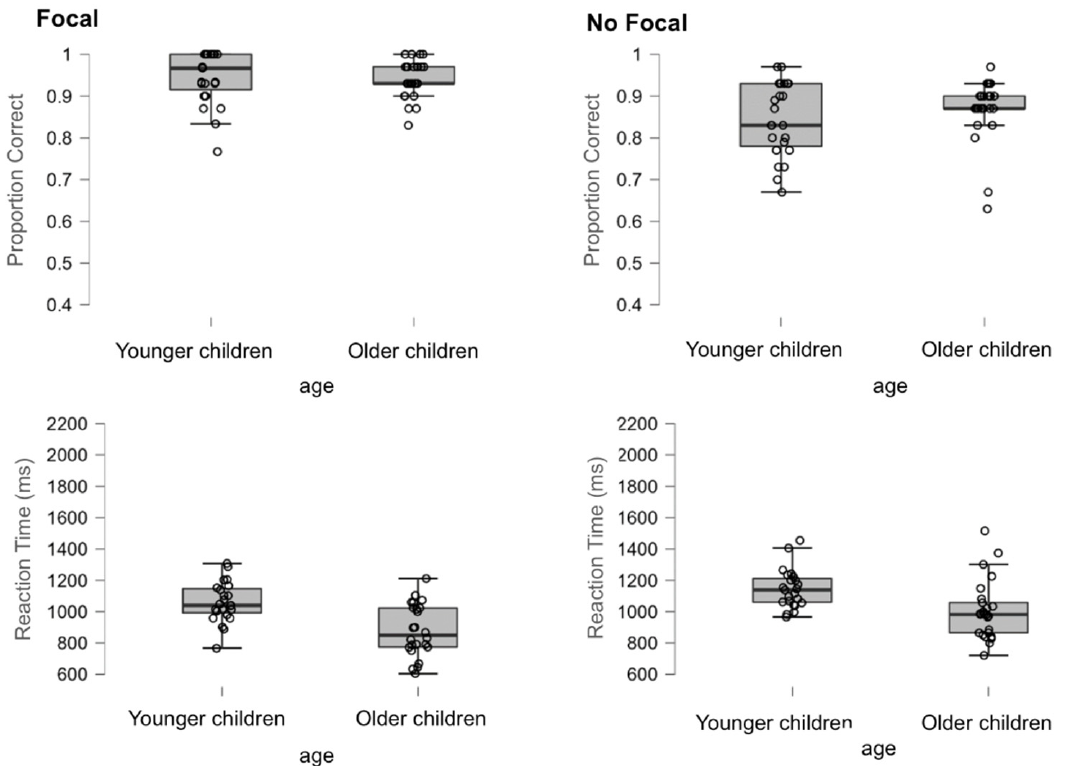
Figure 2. Box plots of correct OT responses ( top panels) and reaction times (in ms, bottom panels) for each group in focal and non-focal